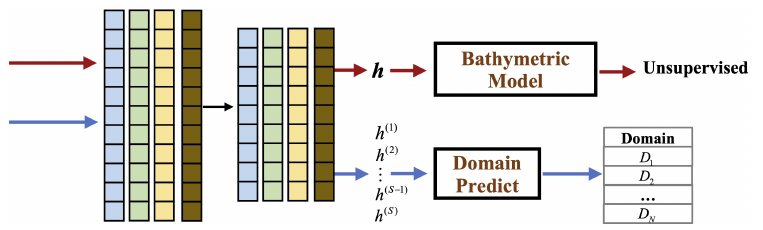
Figure 13. The domain prediction